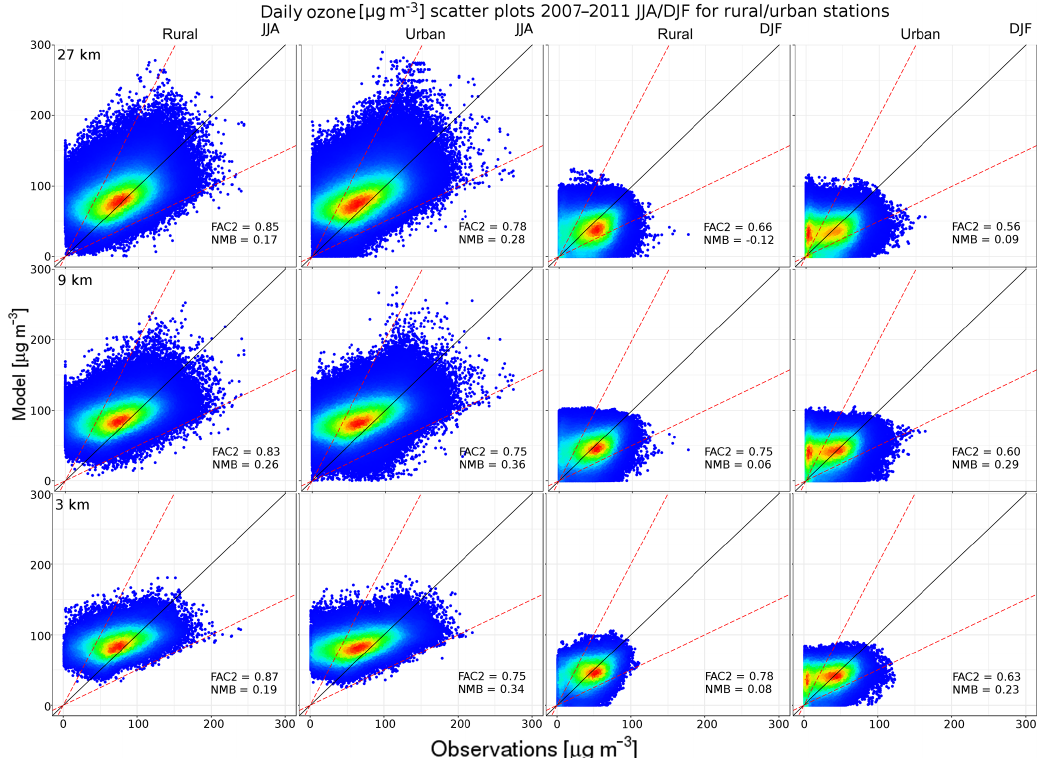
Figure 3. Scatter plots of daily ozone values for JJA (columns 1 and 2) and DJF (columns 3 and 4) for rural and urban stations in µgm − 3 . The rows represent different model resolutions from 27km (top) to 3km (bottom). Dot colors stand for the density of the model–observation pairs. Dashed red lines define the “factor-2” (FAC2) region. Calculated values of FAC2 and the normalized mean bias (NMB) are indicated too.